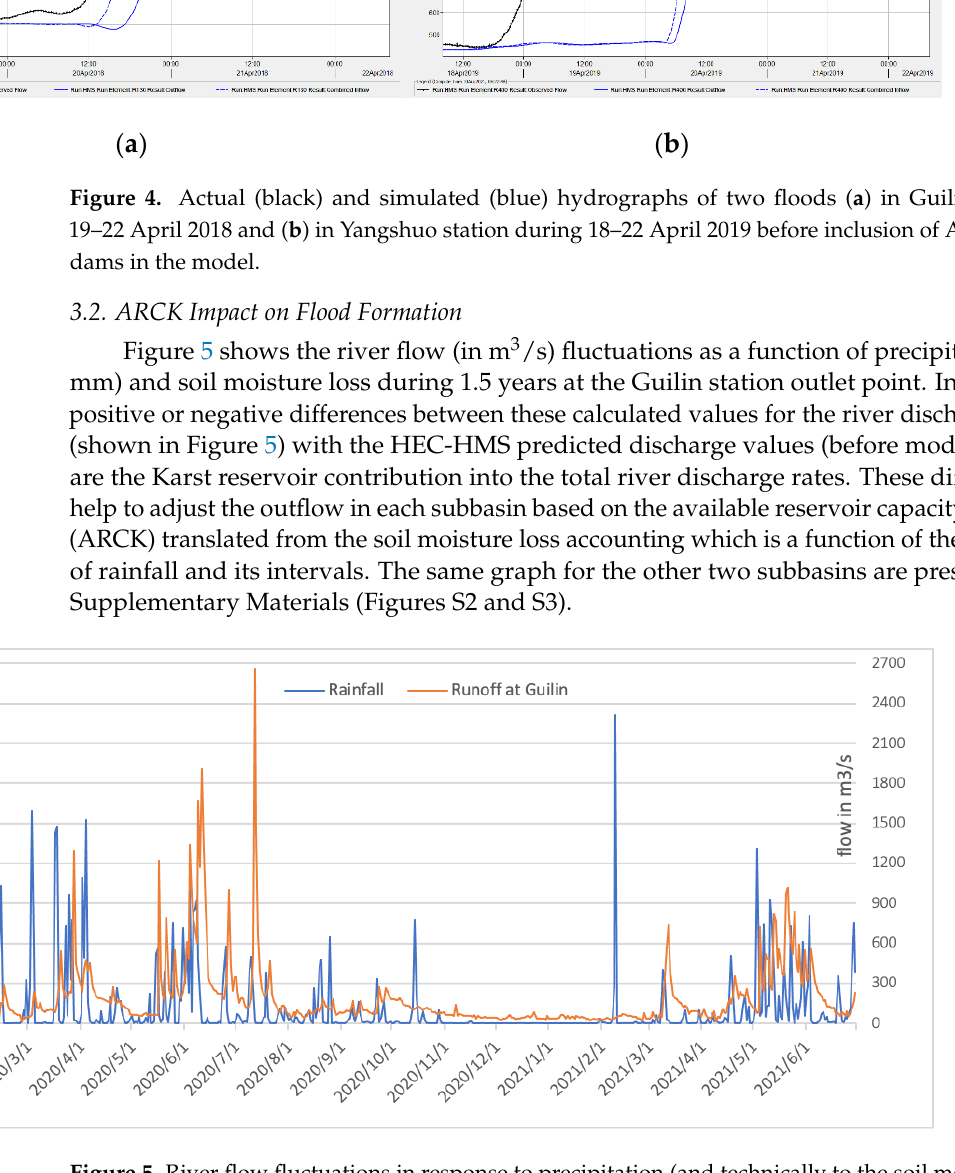
Figure 5. River flow fluctuations in response to precipitation (and technically to the soil moisture) at Guilin subbasin.